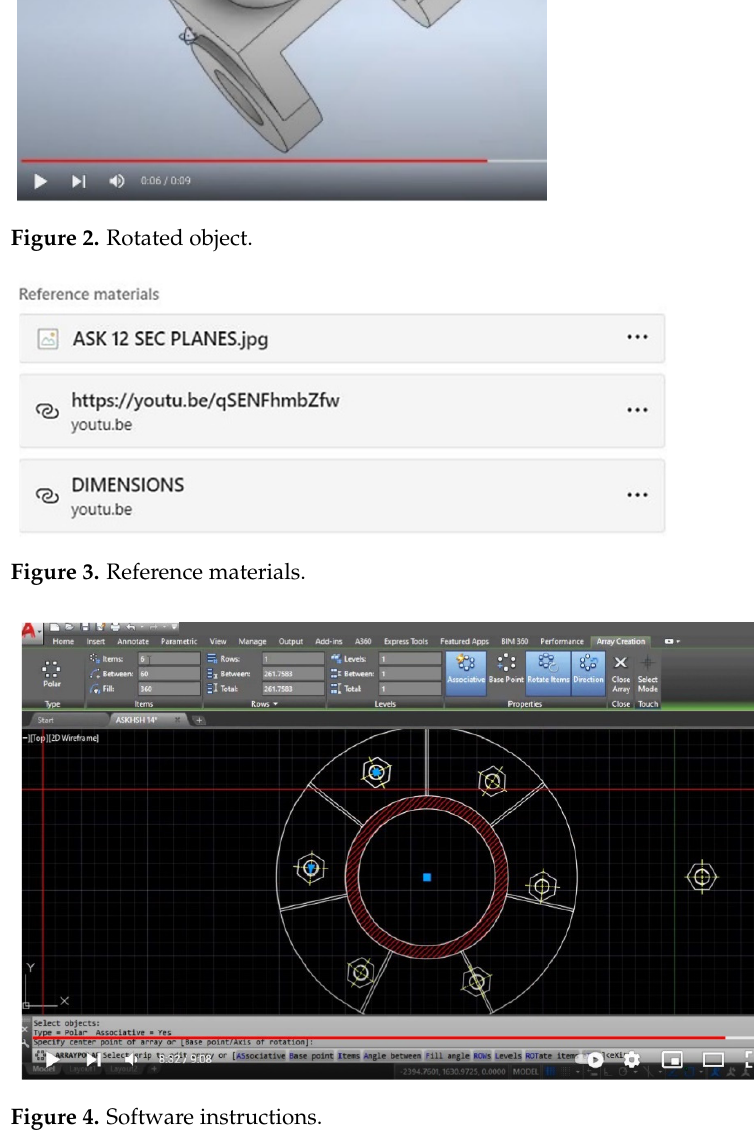
Figure 4. Software